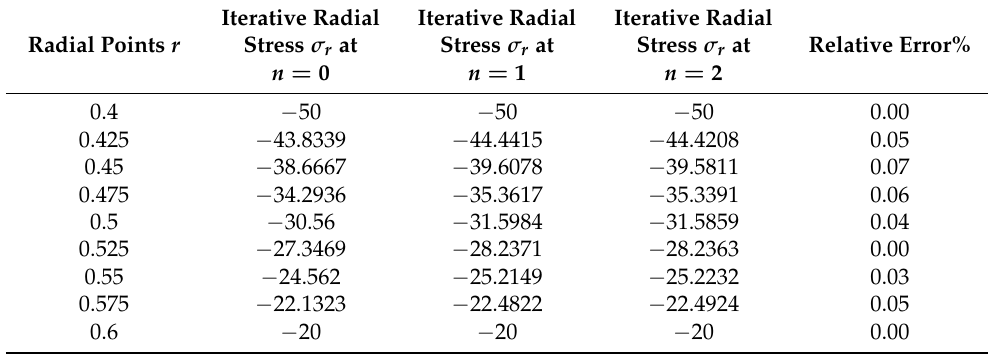
Table 5. Comparison of radial stress σ r in FGM cylinder at n = 0, n = 1 and n = 2 iterations under internal pressure, P a = 50 MPa and external pressure, P b = 20